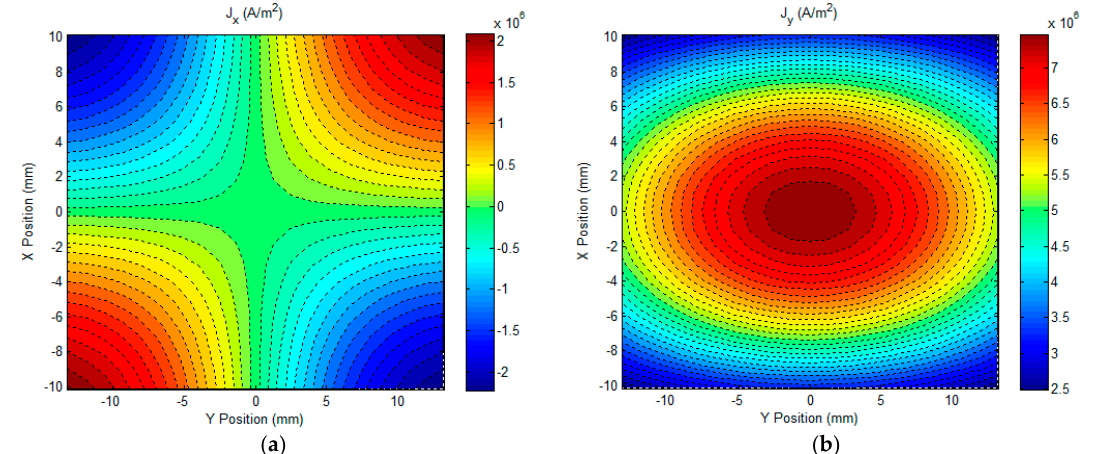
Figure 5. The computed density of eddy currents over the plate back surface. ( a ) x -component of the eddy current density J x ; ( b ) y -component of the eddy current density J y .